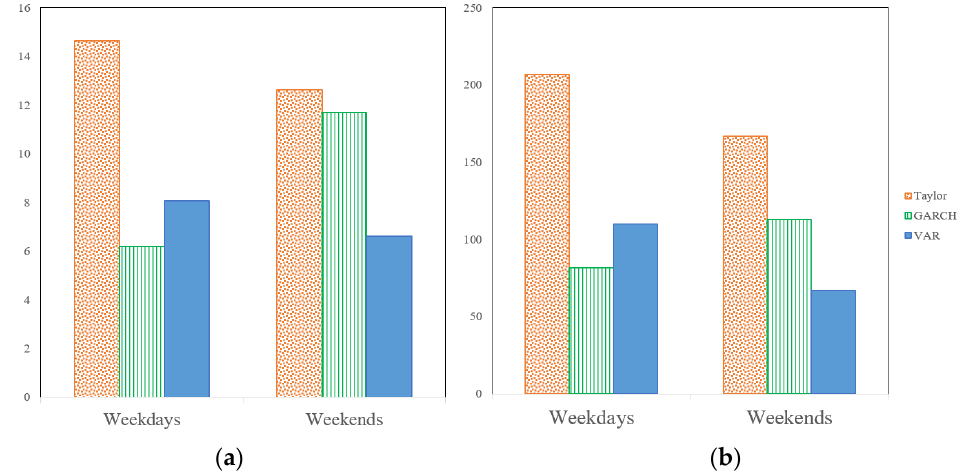
Figure 4. Forecast (k = 8) performance evaluations categorized by day type for models in terms of ( a ) MAPE and ( b ) RMSE.